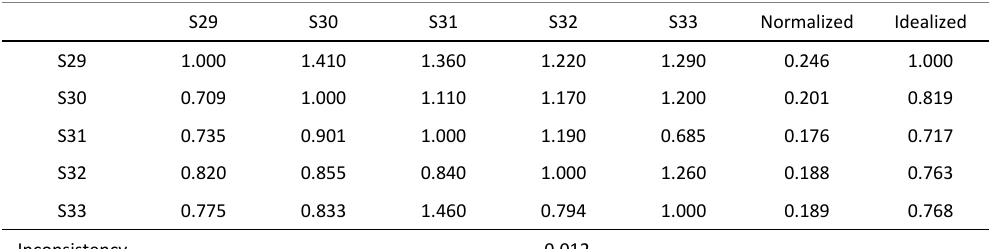
Table 11. Pairwise comparison matrix of individual sub-criteria Table 11: Pairwise comparison matrix of individual